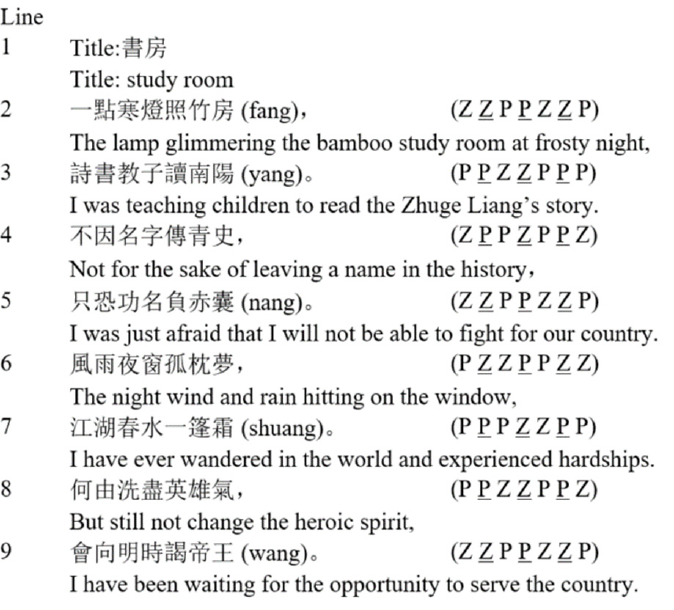
Figure 6. An example of regulated verse generated by our CCPTXL model.